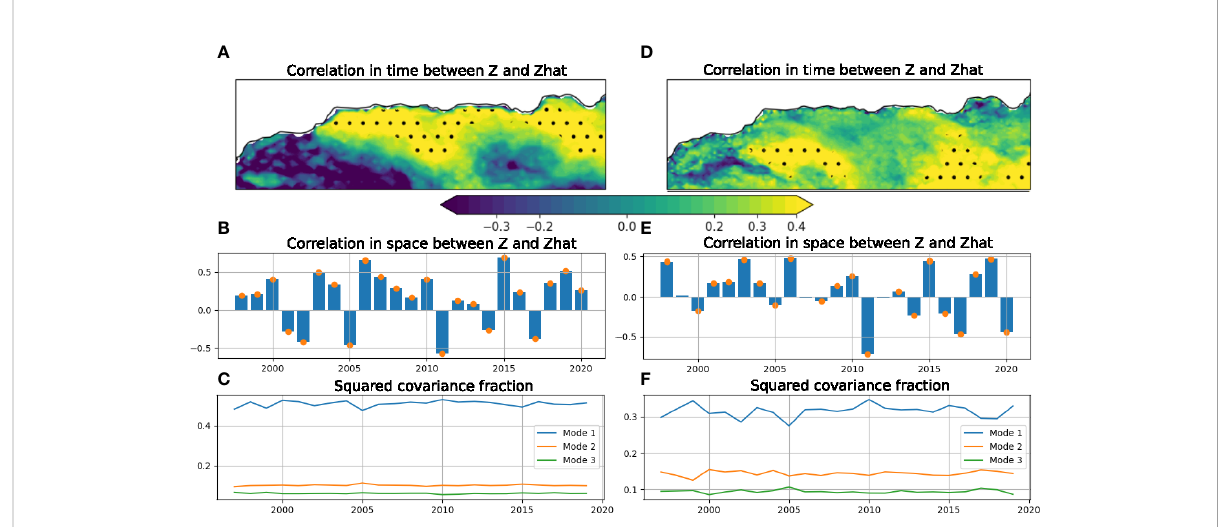
FIGURE 7 Cross-validated hindcast based on MCA (see Section 2.3). From top to bottom: for each spatial location, correlation in time between the observed and the predicted Chl-a signal (A, D) ; for each time, correlation in space between the observed and the predicted Chl-a signal (b,e); and squared covariance fraction explained by each MCA mode (C, F) . Left panels show the Chl-a prediction in March – April from the Paci fi c SSTs in the previous November – December (lag -4); right panels show the Chl-a prediction in March-April from the TNA SSTs in August – September (lag -7). Black marks in the upper panels indicate statistically signi fi cant signals (p-values less than 0.05), based on a Student